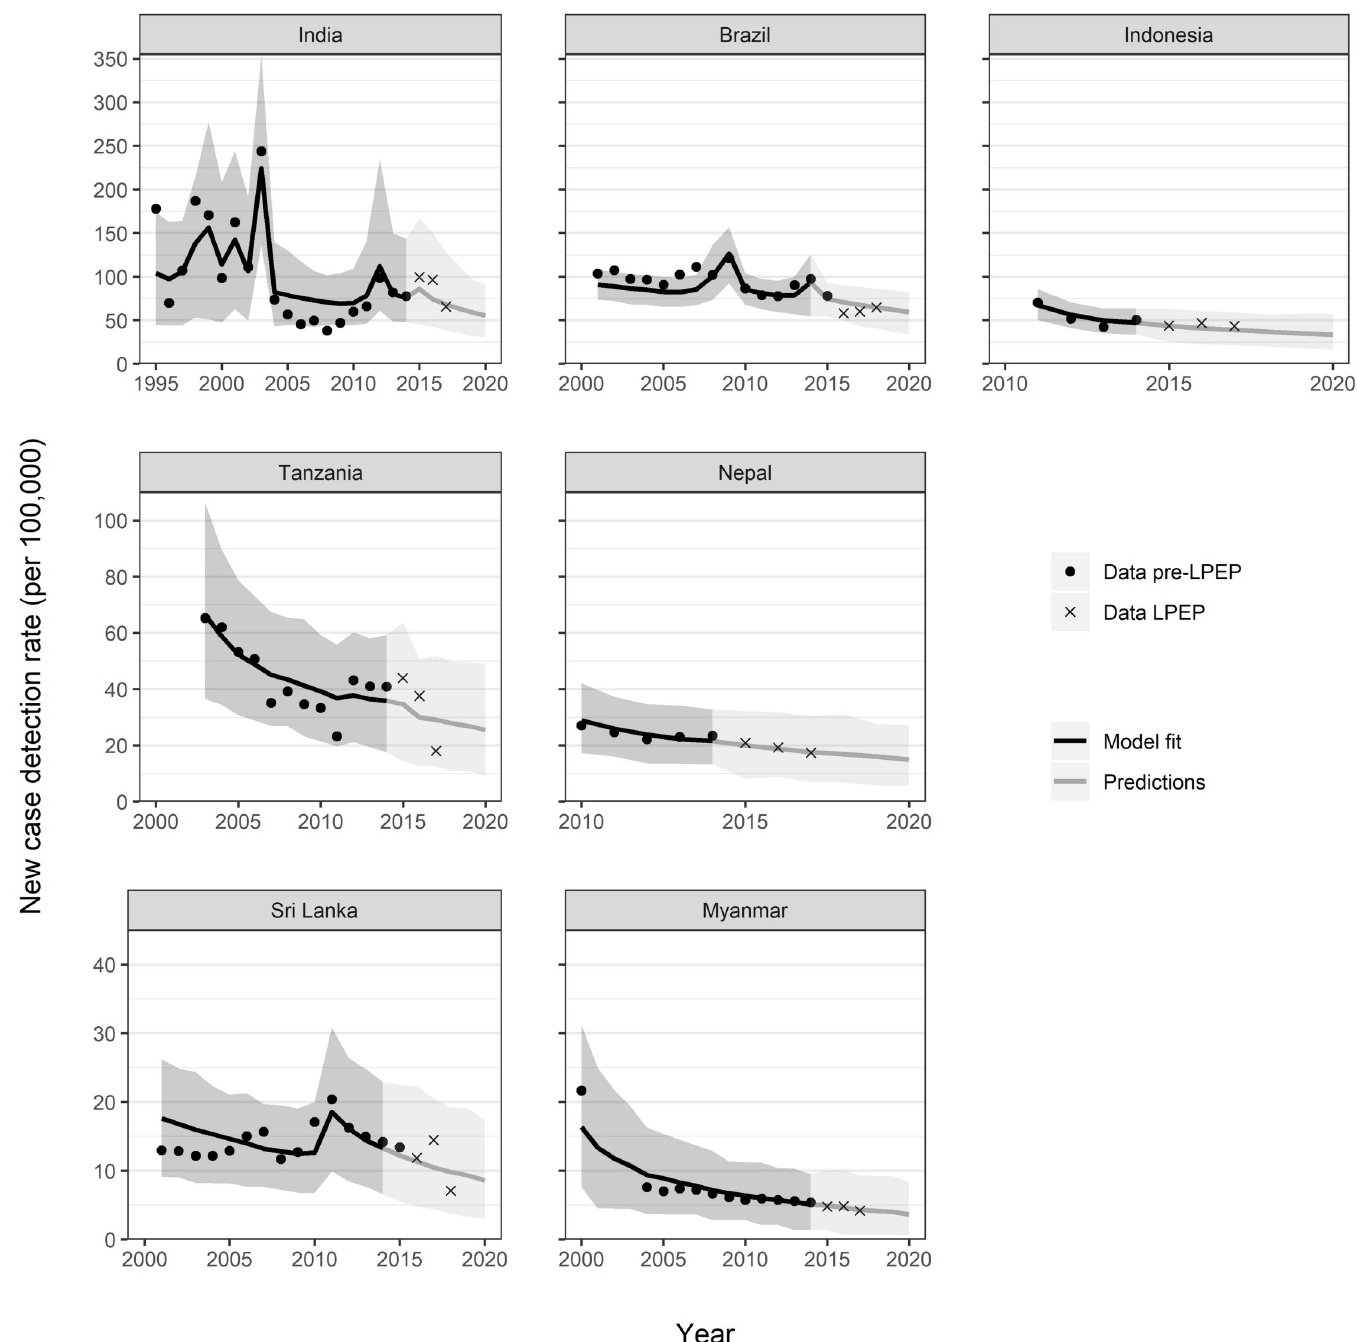
Fig 1. Comparison of modelled trends with the observed leprosy new case detection rates in LPEP areas across states and districts in seven countries. Each panel represents the trends in subnational states or districts (arranged in descending order of baseline endemicity level): India (Union Territory Dadra and Nagar Haveli); Brazil (Alta Floresta city and region and Rondono´polis city in Mato Grosso, Araguaı´na and Colinas do Tocantins in Tocantins, Petrolina city and region in Pernambuco); Indonesia (Sumenep district); Tanzania (Kilombero, Liwale and Nanyumbu); Nepal (Jhapa, Morang and Parsa districts); Sri Lanka (Kalutara and Puttalam districts); Myanmar (Nyaung Oo, Myingyan and Tharyarwaddy Townships). Data are represented by black dots and crosses. The solid line represents the mean model estimate and the shaded area the 95% prediction interval.